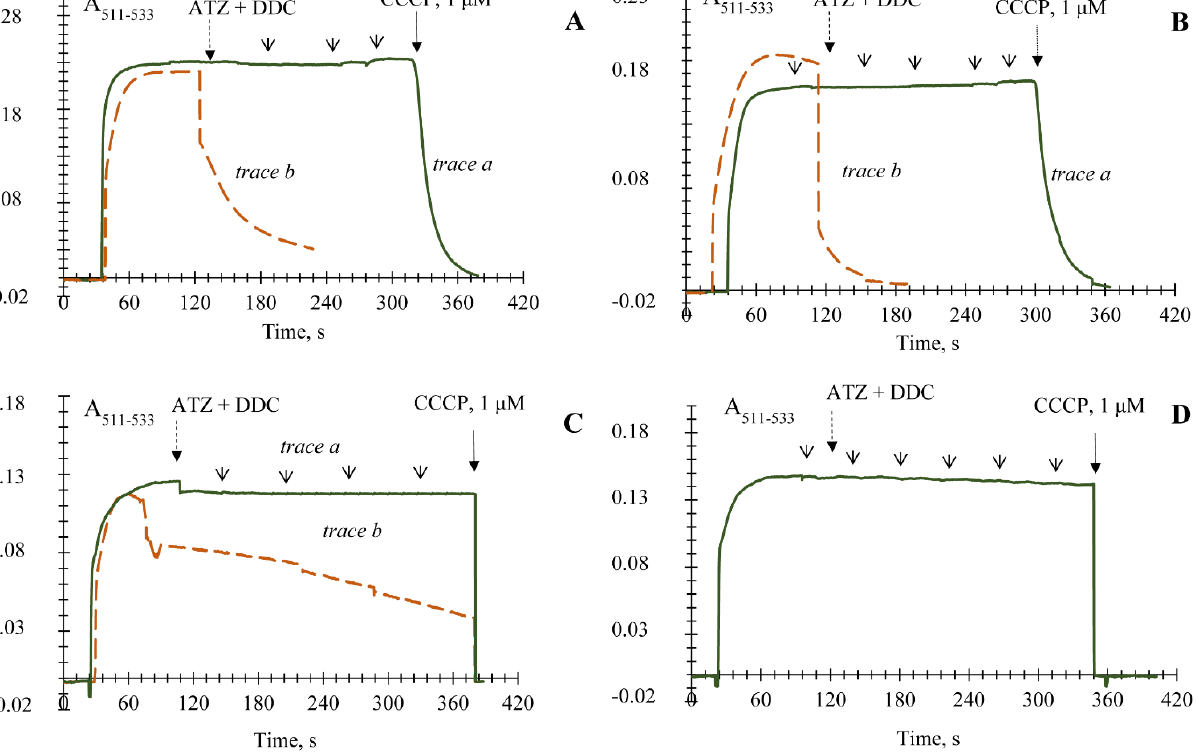
Figure 2. Recording of ∆Ψ generated by the E. magnusii mitochondria respiring on a 20 mM α-ketoglutarate (Panel ( A )), 10 mM succinate (Panel ( B )), 10 mM NADPH (Panel ( C )), and 10 mM NADH (Panel ( D )). The incubation medium contained 0.4 M mannitol, 0.1 M KCl, 20 mM Tris-acetate, 0.4 mg of mitochondria protein, and pH 7.4. Additions and amounts are indicated by large arrows. Trace a—control (solid line); trace b indicates the effect of the addition of 4 mM DDC, and of 4 mM ATZ (dashed line). The additions are indicated by arrows: the solid one for protonophore, 1 µ M CCCP; the dashed one for ATZ and DDC. Small arrows indicate stirring for aeration.